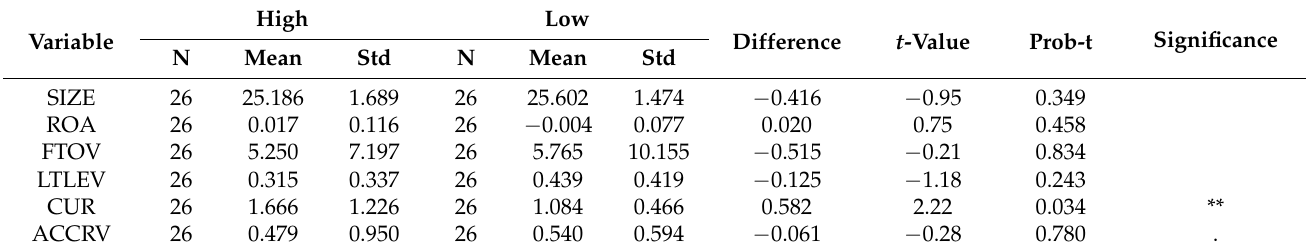
Table 3. The mean difference of TF/IDF on PB between high (1,2) and low (4,5) quintile.